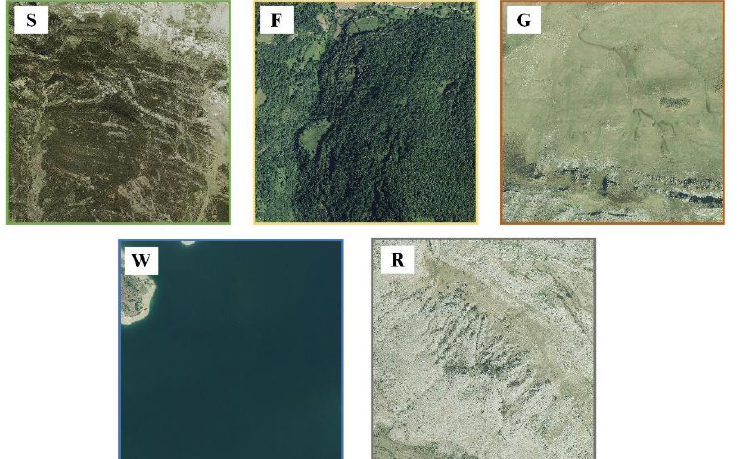
Figure 2. Habitat types identified in study area: shrubland (S), forest (F), grassland (G), water (W), and rock and bare soil (R).